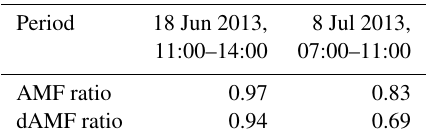
Table 8. Average ratios (simulation results divided by measure- ments) of the O 4 (d)AMFs for the middle periods of the selected